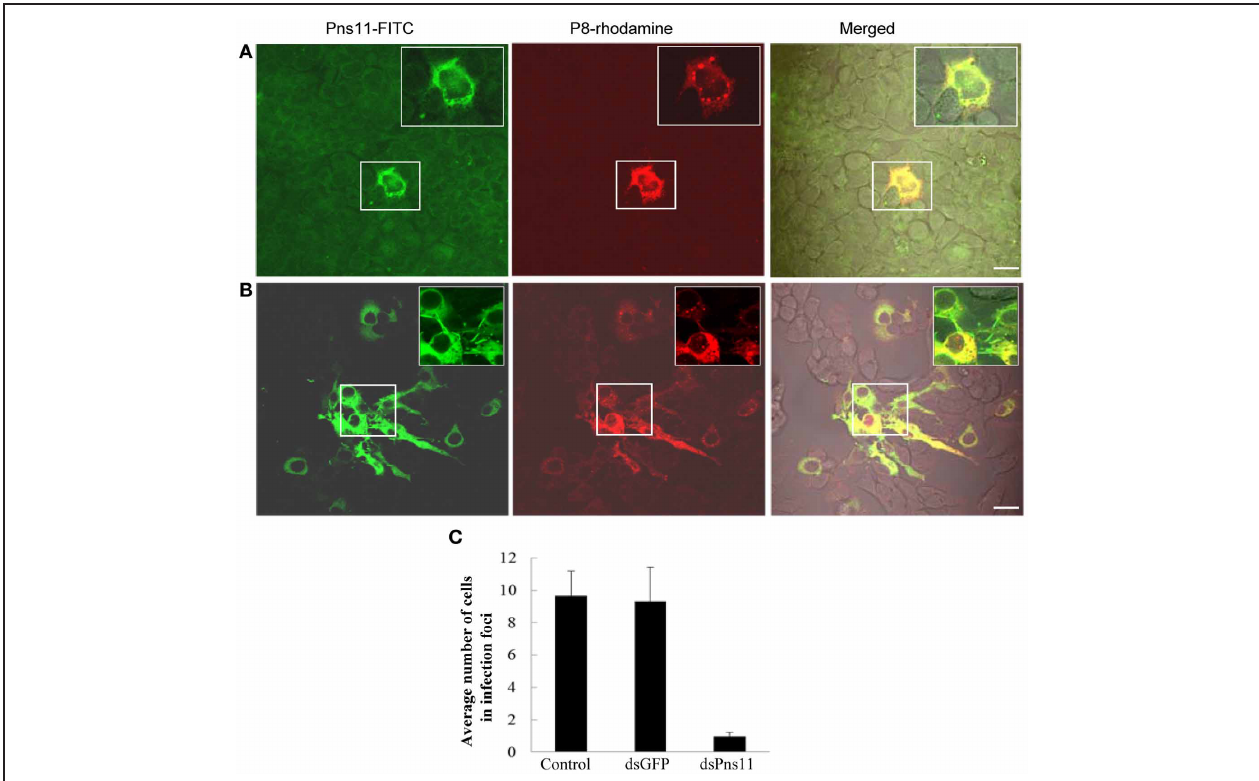
P8-rhodamine, and then examined by confocal microscopy. Bars, 15 µ m. Insets are enlarged images of boxed areas. (C) Mean number of RGDV-infected cells/infection focus in VCMs after treatment with dsRNAs. Error bars indicate standard deviations from three independent